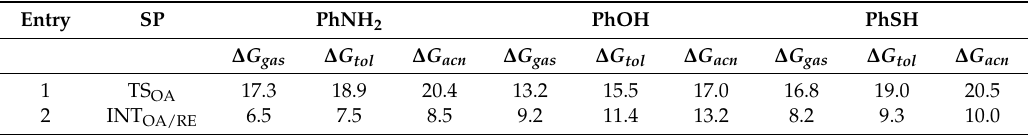
Table 2. Gibbs Free Energies (kcal/mol) for Key Stationary Points (SP) in the mechanisms of Ullmann-Type X -Arylation Reactions ( X = NH, O, S) in different solvents 1